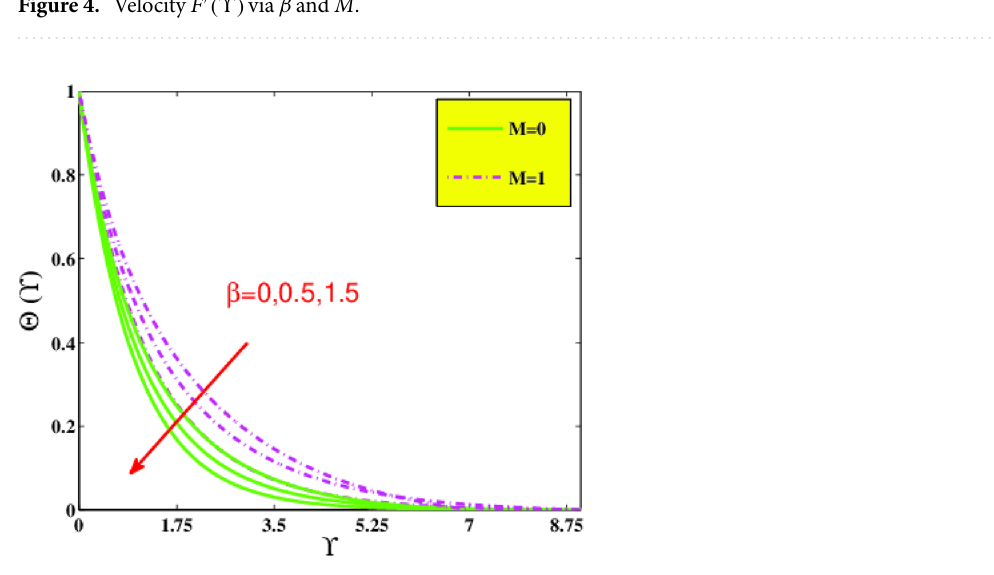
Figure 5. Temperature �(ϒ) via β and M